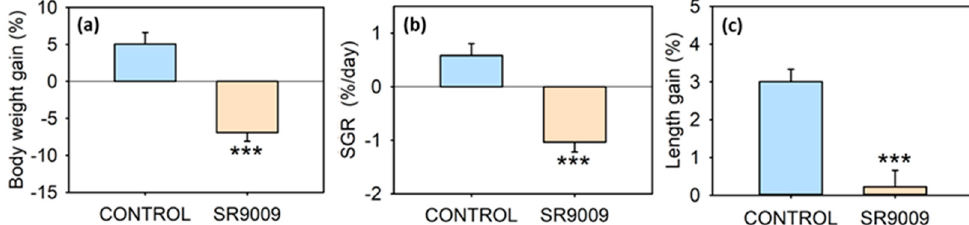
Figure 2. Effect of subchronic SR9009 treatment on growth of goldfish ( Carassius auratus ). Relative weight gain ( a ), specific growth rate ( b ), and relative standard length gain ( c ), over the 7 days of the subchronic IP administration of vehicle alone (CONTROL) or containing SR9009 (100 µg/g bw) ( n = 12 fish/group). Data are expressed as mean + S.E.M. *** p < 0.001 SR9009 compared to control group (Student’s t -test).